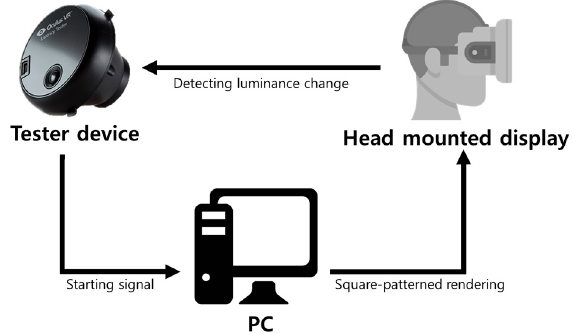
Figure 2. Conventional latency measurement device: Oculus latency tester ( a ) before installing latency tester and ( b ) after installing latency tester.